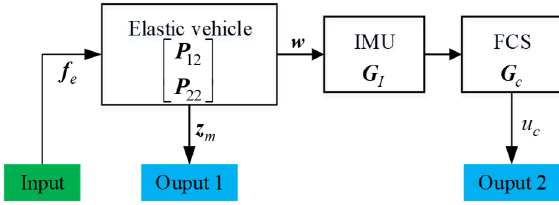
Figure 6. Block diagram of shaker excitation.